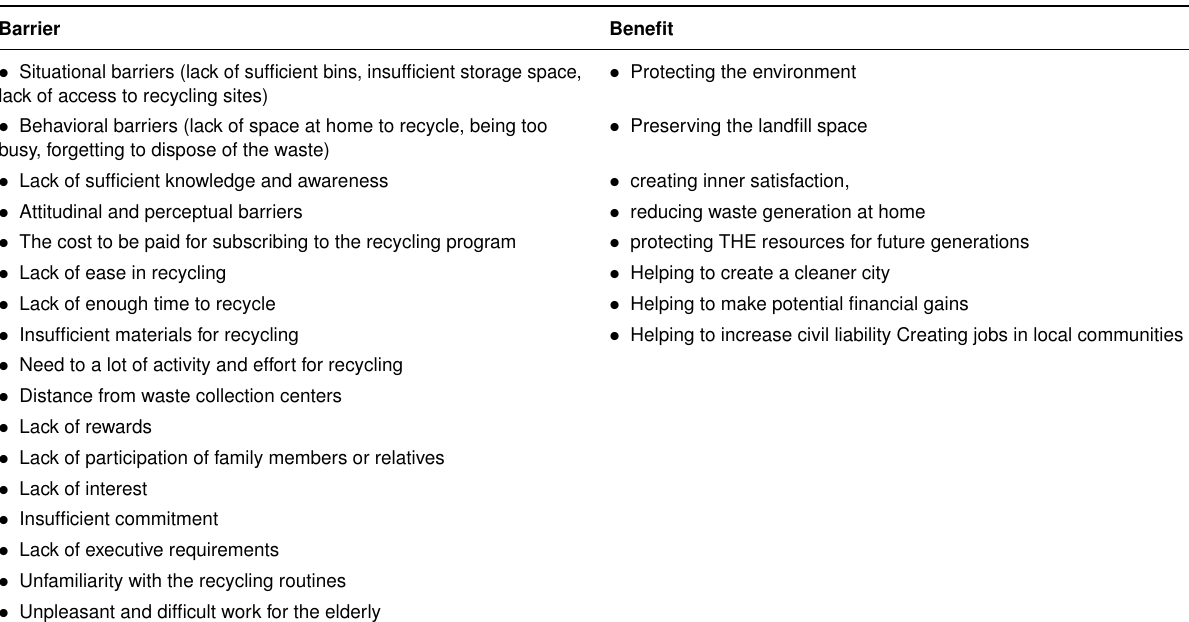
Table 1. Barriers and benefits identified based on literature